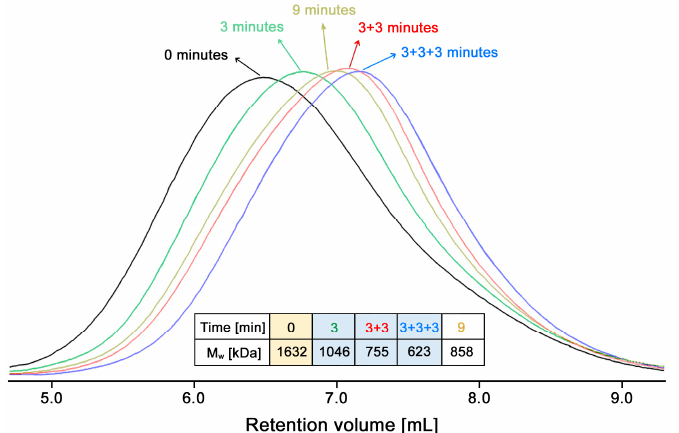
Figure 10. GPC chromatograms of chitosan treated with ultrasound for 9 min straight and for a sequence of three 3-min treatments.